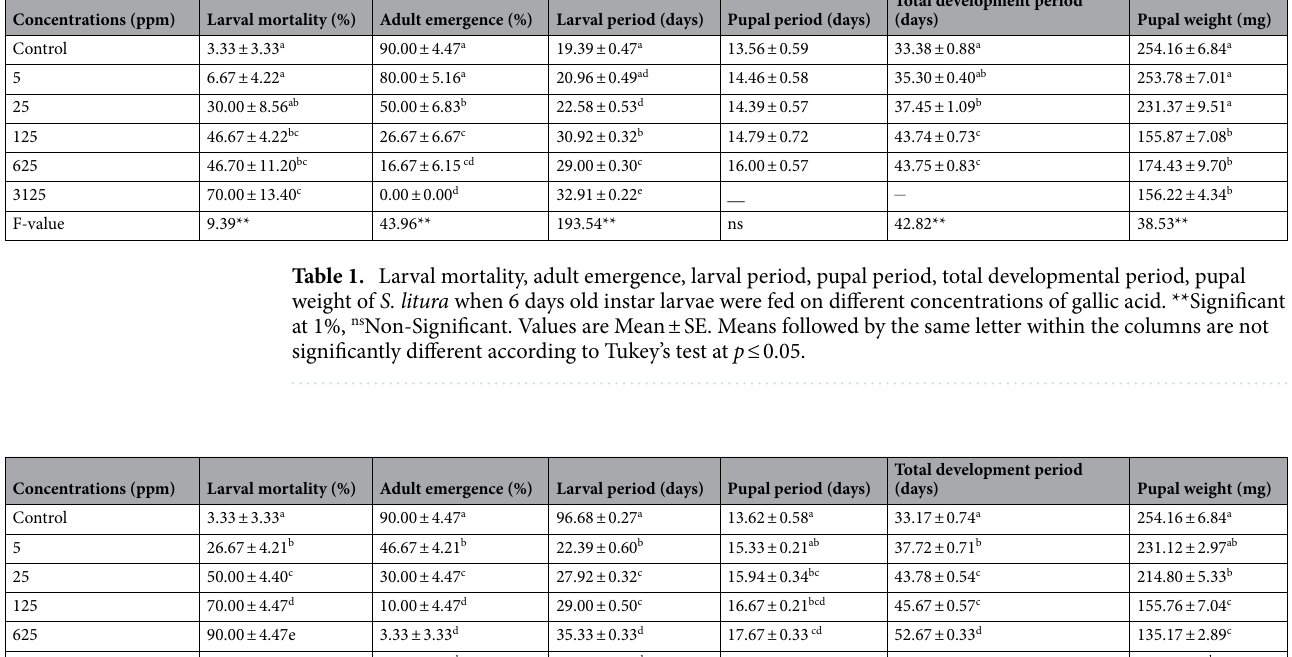
Table 2. Larval mortality, adult emergence, larval period, pupal period, total developmental period, pupal weight of S. litura when 6 days old instar larvae were fed on different concentrations of azadirachtin. **Significant at 1%. Values are Mean ± SE. Means followed by the same letter within the columns are not significantly different according to Tukey’s test at p ≤ 0.05.